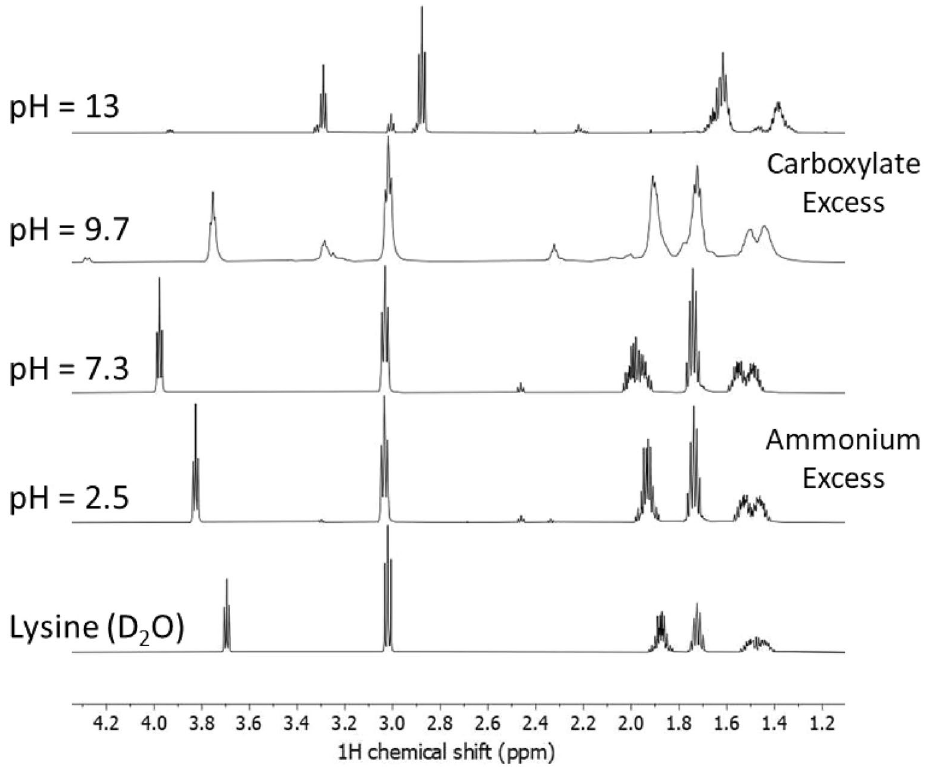
Figure 4. 1 H NMR spectra of the l-lysine samples after hydrothermal treatment at 130 °C using aqueous solutions at different pH. From bottom to top: untreated l-lysine and pH 2.5, 7.3, 9.7, and 13.